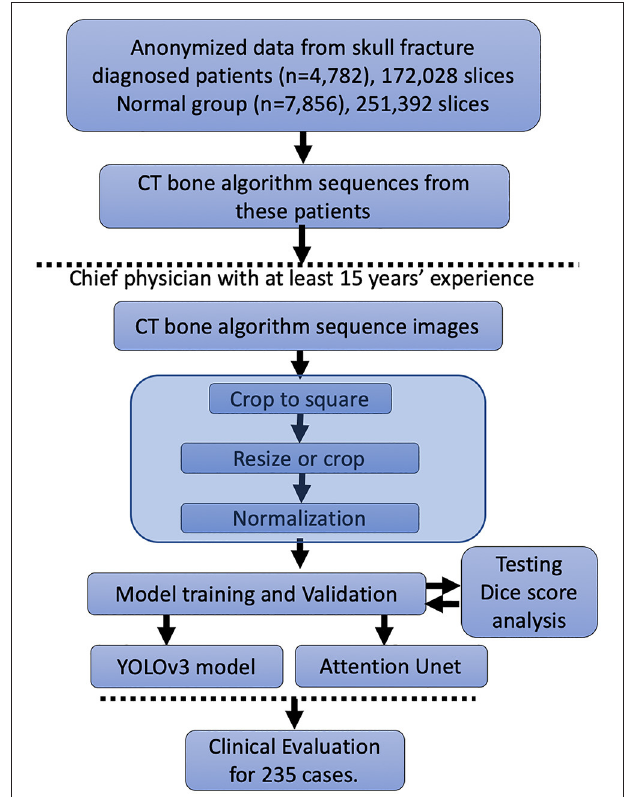
FIGURE 1 | Workflow of the